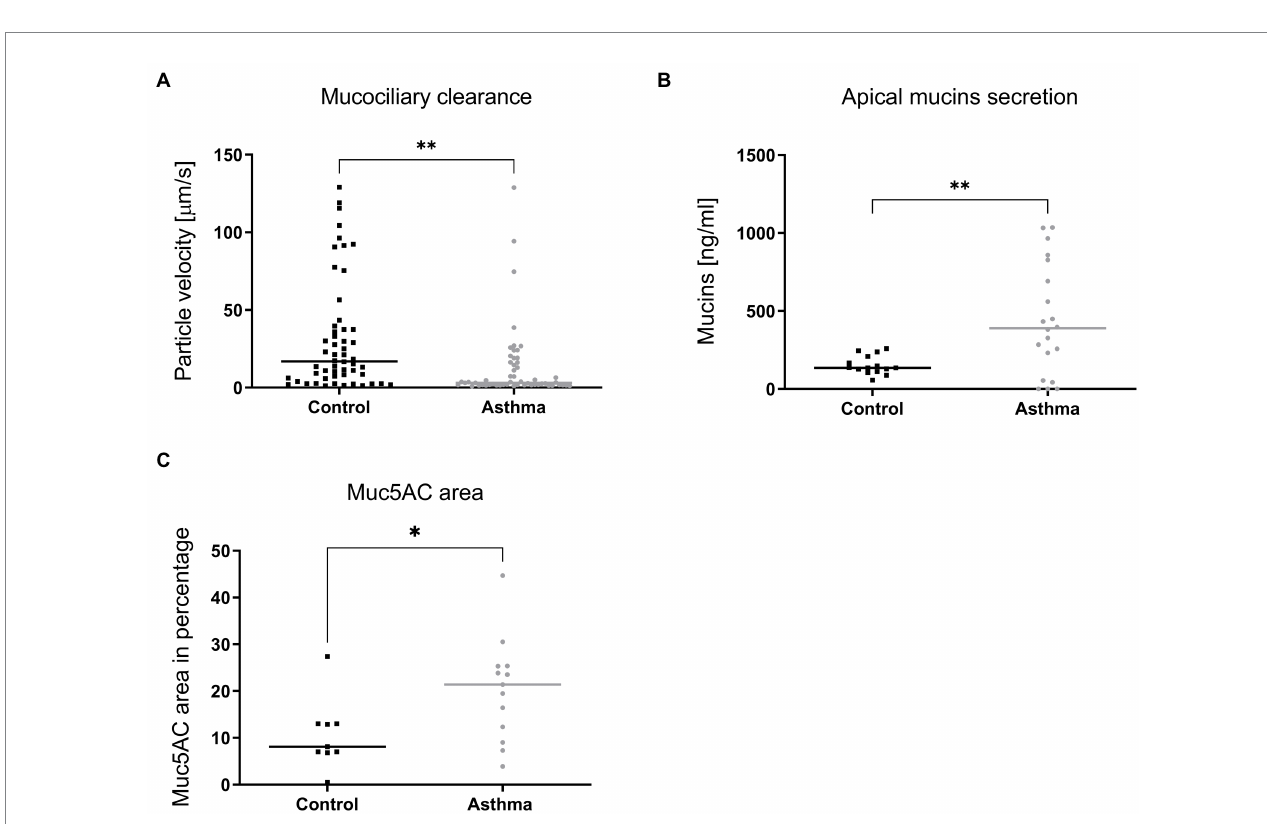
FIGURE 6 Mucociliary clearance (A) , mucus secretion (B) and expression of Muc5AC in immunostained tissue sections (C) compared in tissues derived from control or asthmatic donors. In A , 9 controls (54 inserts) and 7 asthmatic (55 inserts) donors were included in the comparison. In B , mucins were quantified from apical samples collected after 24h from tissues derived from 4 controls (15 inserts) and 5 asthmatic (20 inserts) donors. In C , tissues derived from 9 control and 9 asthmatic donors were processed. Statistically significant differences between HAE from asthmatic or control donors are indicated. * p < 0.05; ** p <